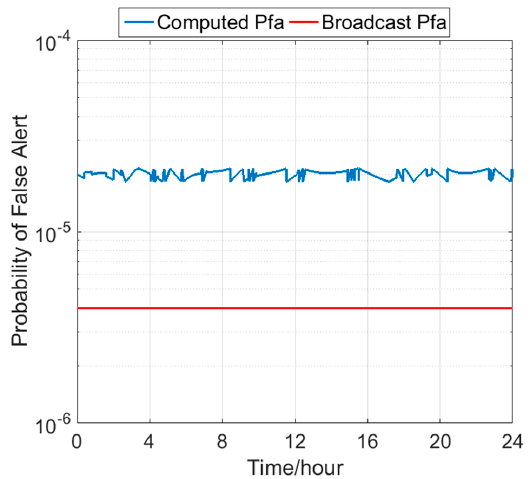
Figure 7. Comparison between the Pfa in the ISM and the computed Pfa on March 1, 2017.